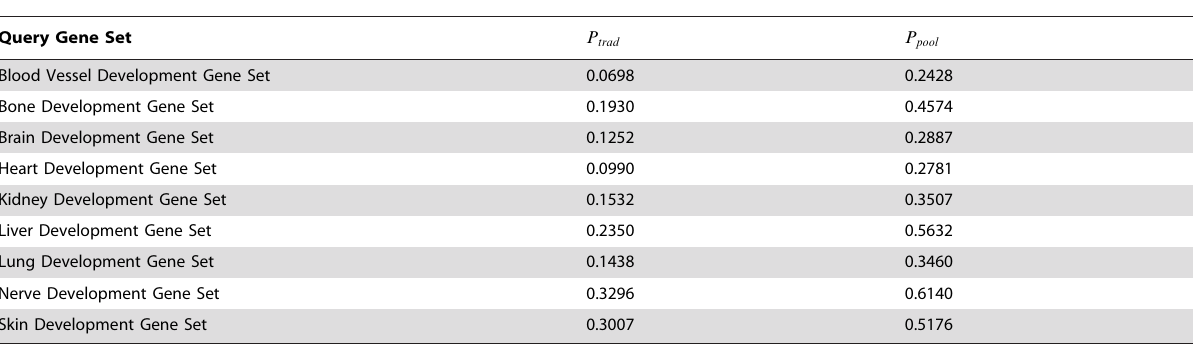
Table 1. Advantage of the pooling